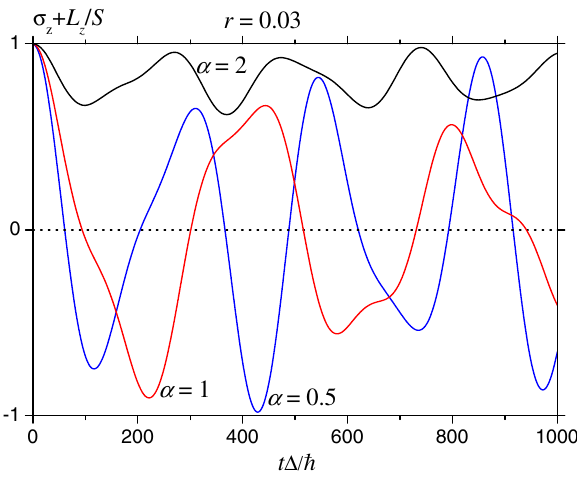
FIG. 7. Time dependences of h (cid:1) classical approaches. In the semiclassical approach, decoherence is apparent. and freezing of tunneling at (cid:3) > 1 [Fig. 7(b)] are z